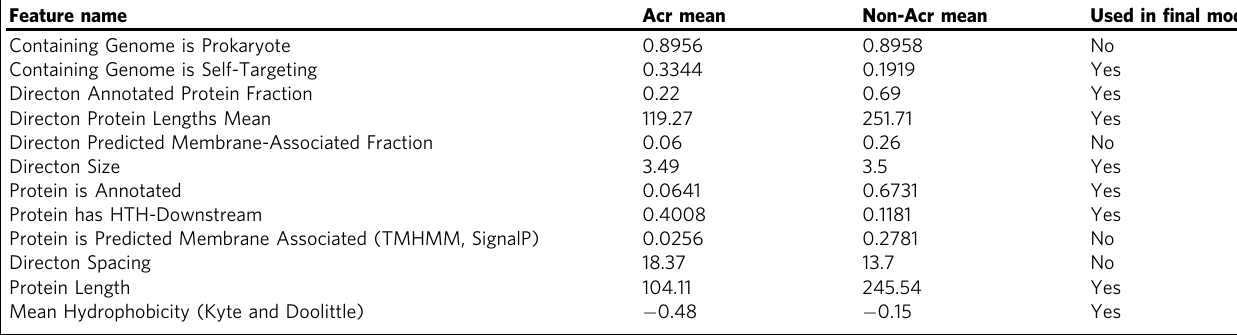
Table 1 Feature set. Weighted means of all assessed features, and whether they were used in the fi nal